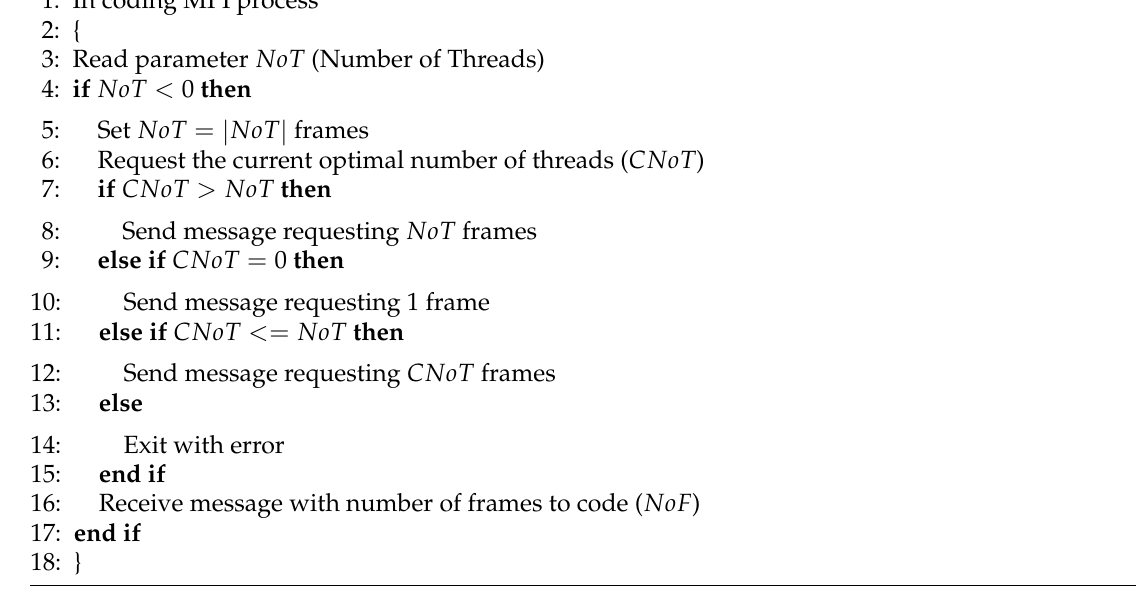
Algorithm 3 Improved setting the number of threads in the DSM-AI algorithm 1: In coding MPI